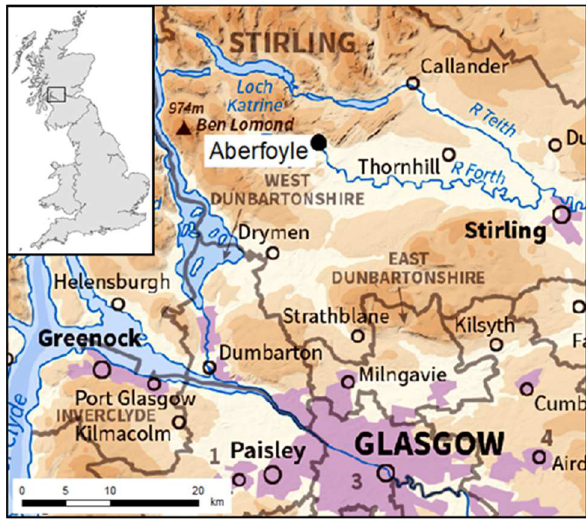
Figure 10. Location of the study area – Queen Elizabeth Forest Park near Aberfoyle, United Kingdom. © Crown Copyright and Database Right 2015. Ordnance Survey (Digimap